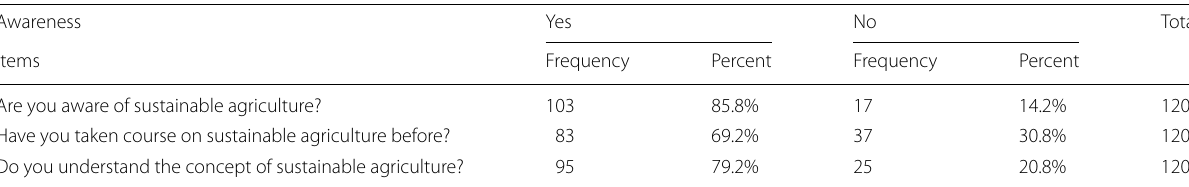
Table 1 Students’ awareness of sustainable agriculture as climate change strategy